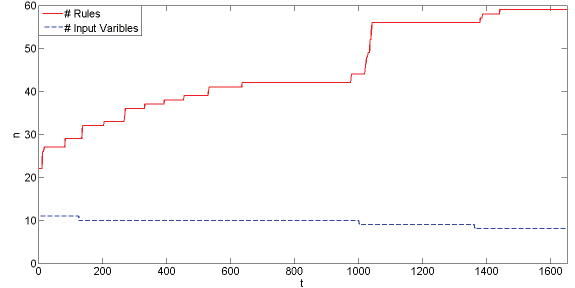
Table 2. Best model parameters: sphere position prediction.